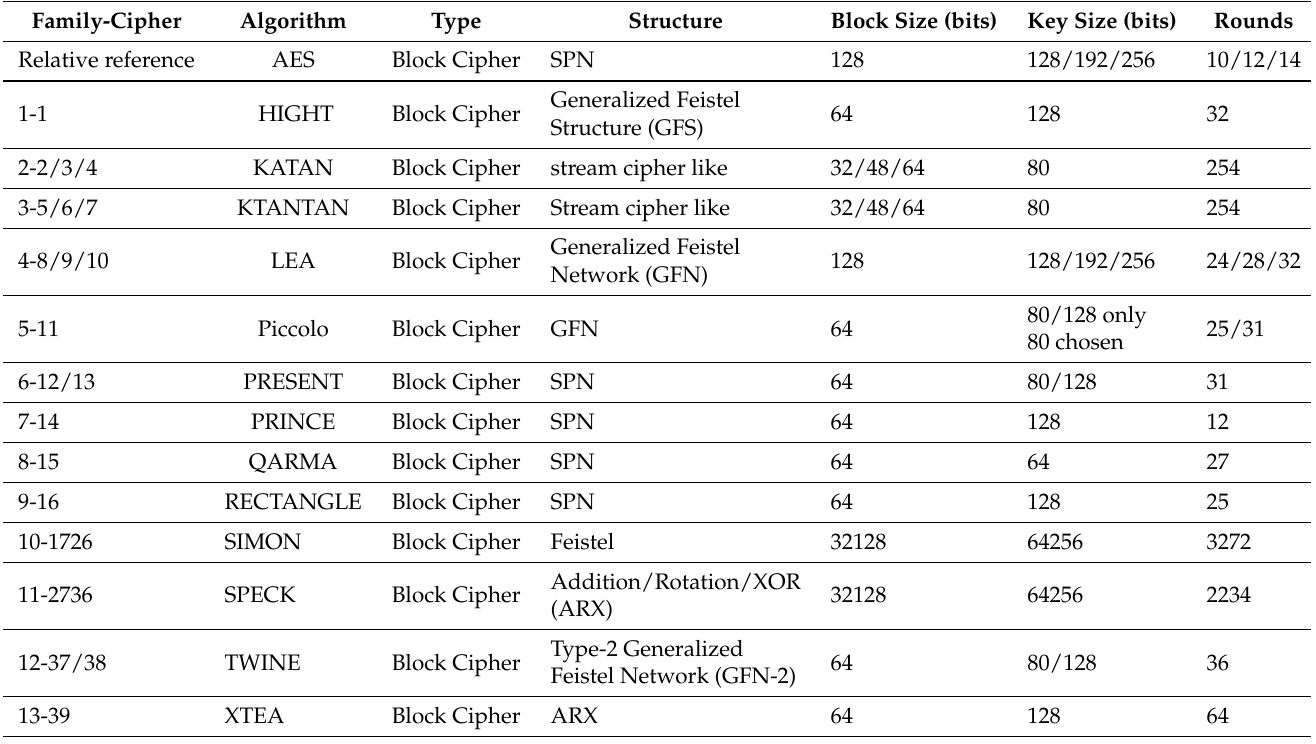
Table 1. Thirty-nine algorithms and AES as a relative